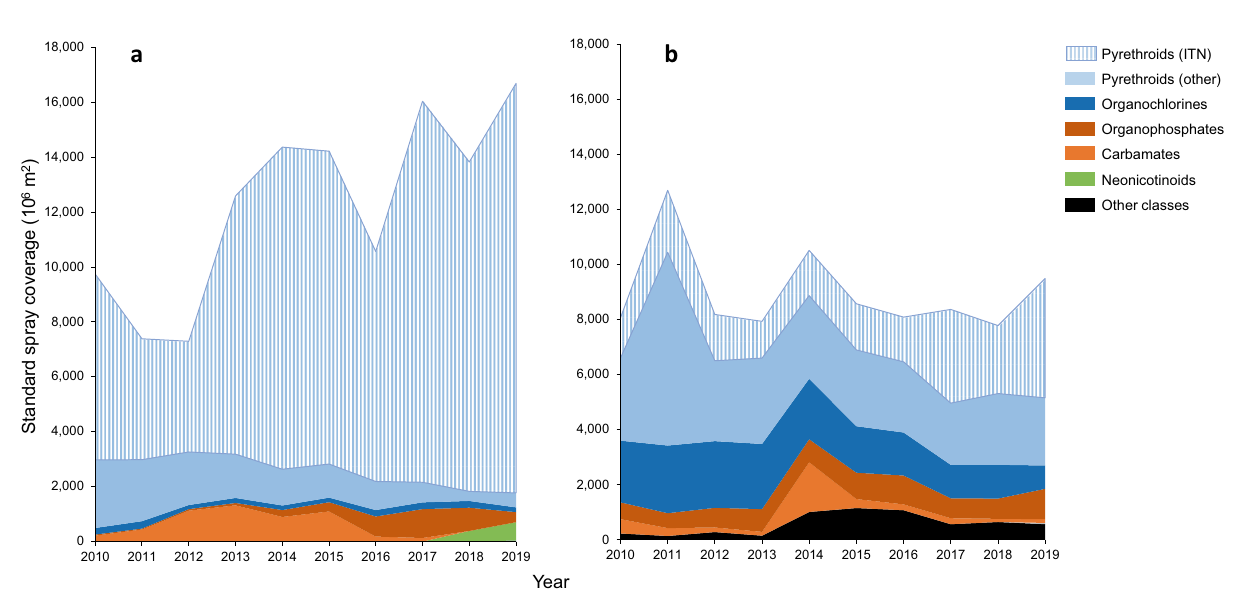
Figure 3. Area graph of vector control insecticide use by insecticide class. ( a ) African Region, ( b ) Asia–Pacific Region plus Latin American & Caribbean Region combined. Results are pooled for the four selected diseases and expressed in standard spray coverage. Striped pattern indicates use of insecticides in ITNs; non-striped pattern indicates use in spraying operations (i.e., residual spraying, space spraying, larviciding). Shades of blue or shades of red indicate insecticide sub-groups within a mode of action 21 . ‘Other classes’ represent bacterial larvicides, insect growth regulators, spinosyns, and